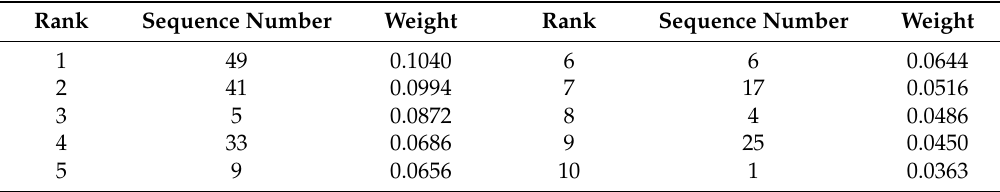
Table 9. Weights of the first 10 features in 2015.